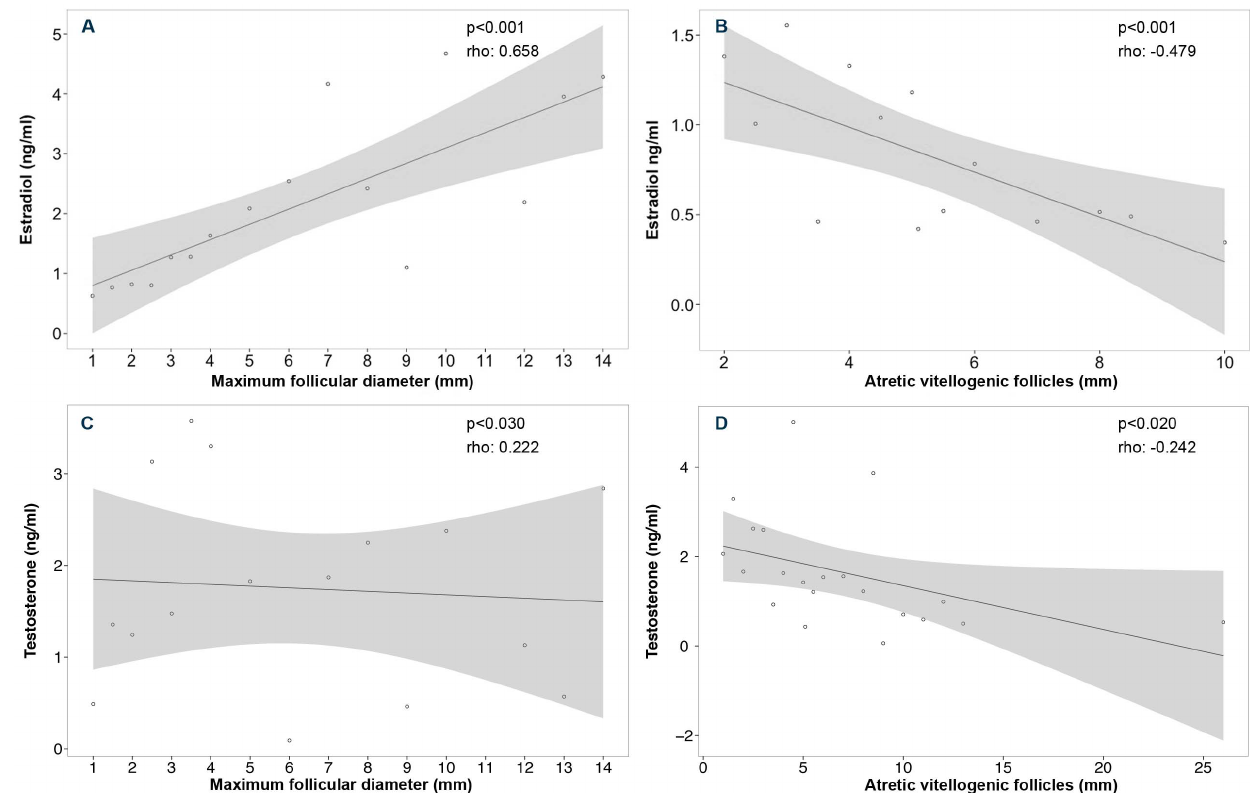
Figure 5. Relationship between plasma levels of hormones and ovarian follicles in Rhizoprionodontaylori . Changes in 17 b -estradiol were significantly correlated with (A) maximum follicular diameter, and (B) atretic vitellogenic follicles observed from February to October. A weak correlation was observed between testosterone and (C) maximum follicular diameter, and (D) atretic vitellogenic follicles observed from February to October. Graphs show the correlation, including regression line and confidence interval of 95% represented by the shaded area.